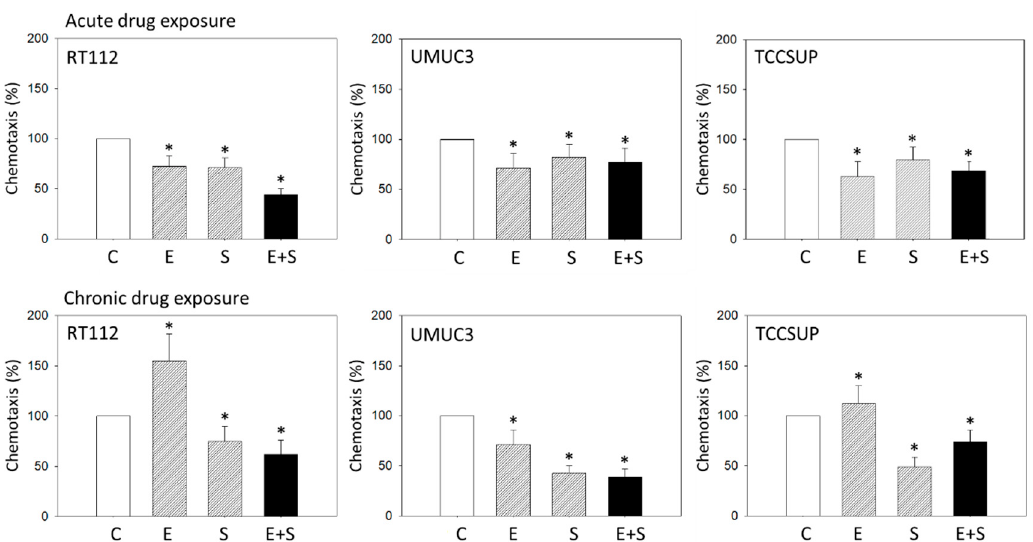
Figure 2. Chemotaxis of RT112, UMUC3, and TCCSUP cells exposed to 0.5 nM everolimus (E), 2.5 µM sulforaphane (S), or 0.5 nM everolimus + 2.5 µM sulforaphane (E + S). Control cells (C) remained unexposed (set to 100%). Mean number of migrating tumor cells from five fields after 24 h incubation. Bars indicate standard deviation, * indicates significant difference to corresponding control, p ≤ 0.05. n = 5.